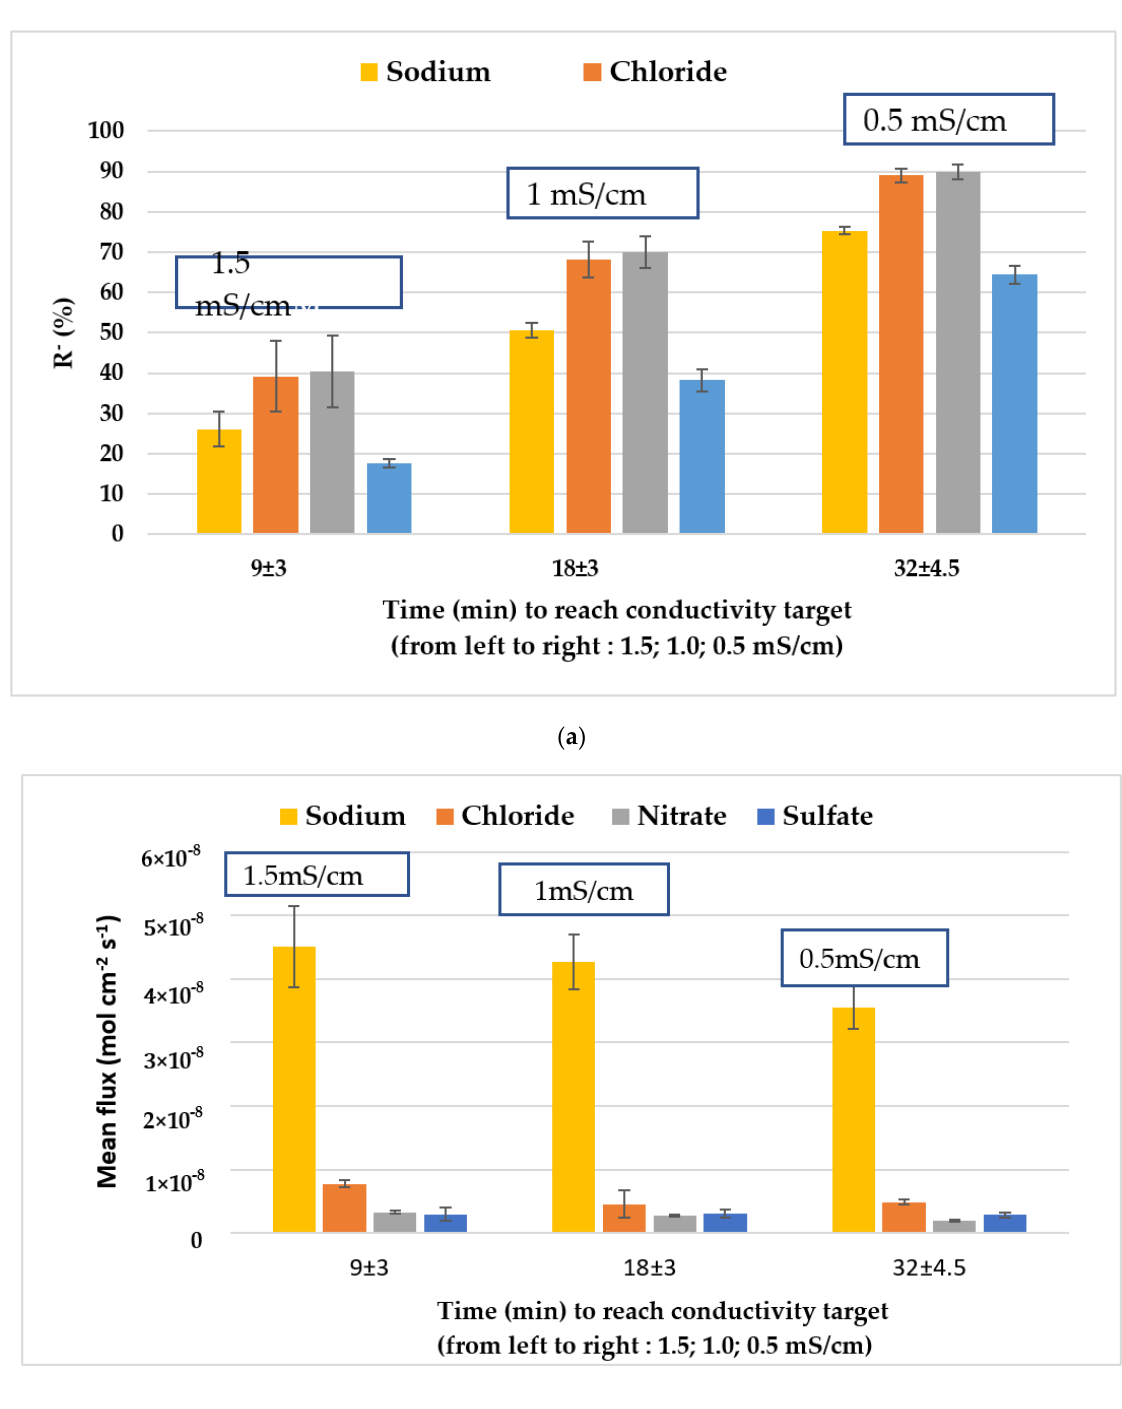
Figure 7. ( a ) Mean removal rate R − (%) calculated rate for Na + , Cl − , NO 3 − , and SO ₄2− for three experiments performed on dialysis RO rejects as a function of the mean time of treatment to reach each conductivity target; ( b ) variation of their fluxes as a function of time of process.